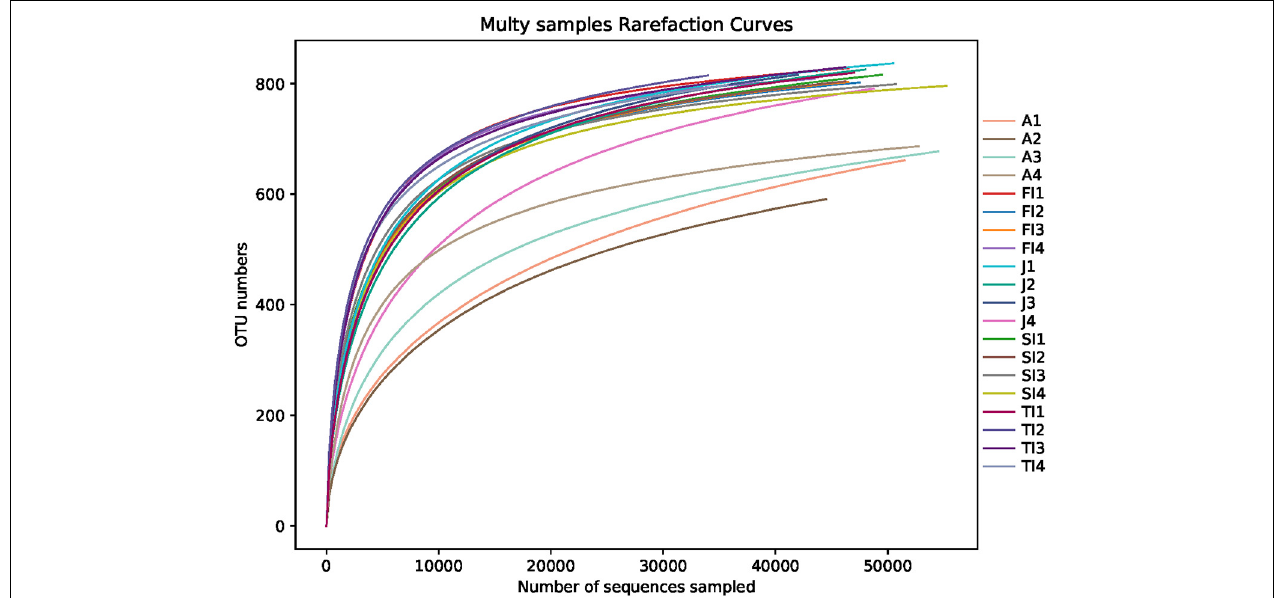
FIGURE 1 | Rarefaction curves of samples. FI, first instar larvae; SI, second instar larvae; TI, third instar larvae; J, juvenile; A, adult.